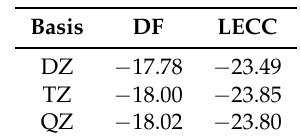
Table 4. The calculated values of E eff (in GV/cm). The triple zeta (TZ) result is at 800 au virtuals’ cut-off value, and QZ at 500 au.